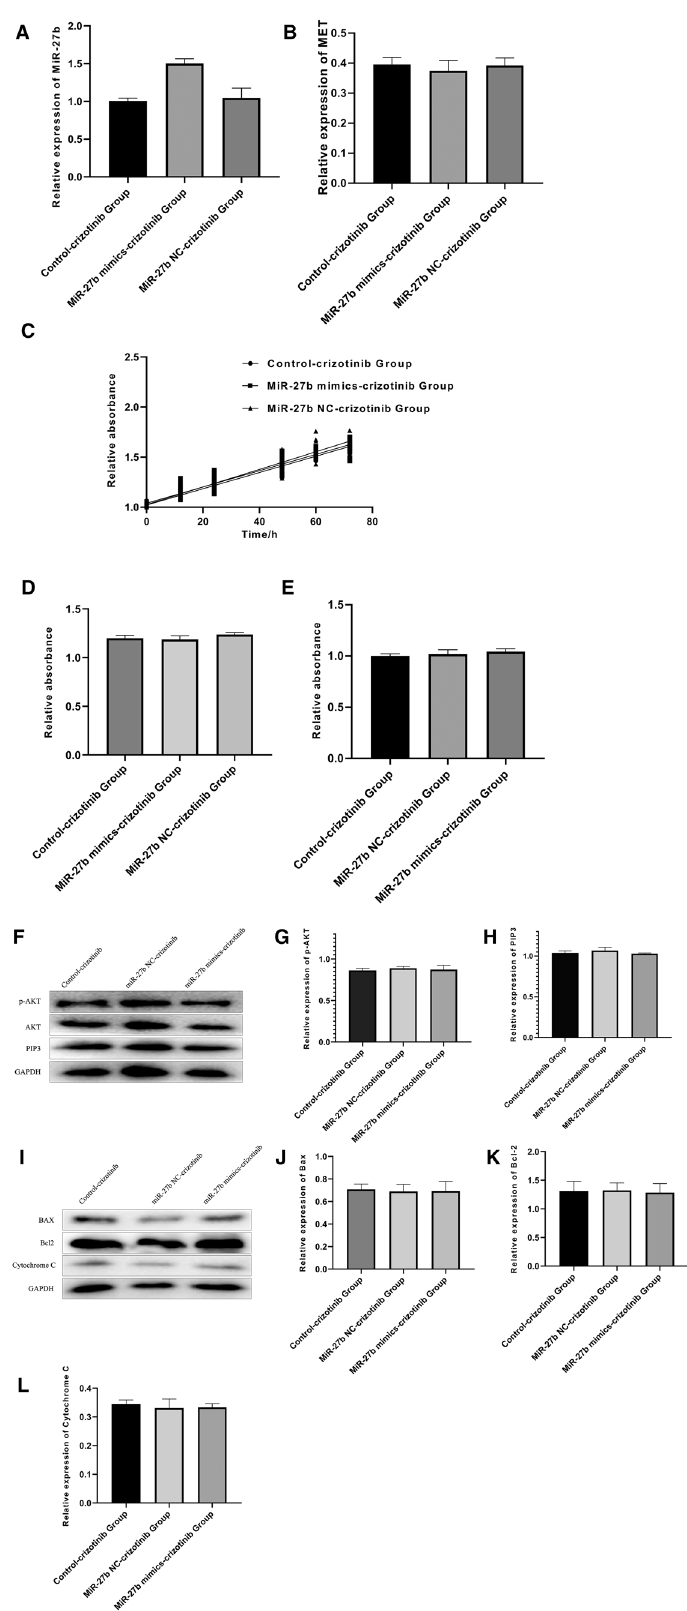
Fig. 6 Inhibiting the activa- tion of MET can eliminate the effects of the activity of PI3K/AKT pathway, prolifera- tion and apoptosis of cells. A : miR-27b expression was determined by qRT-PCR; B : MET expression was deter- mined by qRT-PCR, without statistical difference between groups (P < 0.05); C : The pro- liferation was determined by MTT assay, without statistical difference between groups (P < 0.05), D : The invasiveness of cells was determined by Transwell invasiveness assay, without statistical difference between groups (P < 0.05), E : The apoptosis was deter- mined by ELISA, without statistical difference between groups (P < 0.05); F – H : The expressions of AKT, p-AKT and PIP3 in each group were determined by Western blot, without statistical difference between groups (P < 0.05); I – L : The expressions of Bax, Bcl-2 and cytochrome C were determined by Western blot, without statistical difference between groups (P <